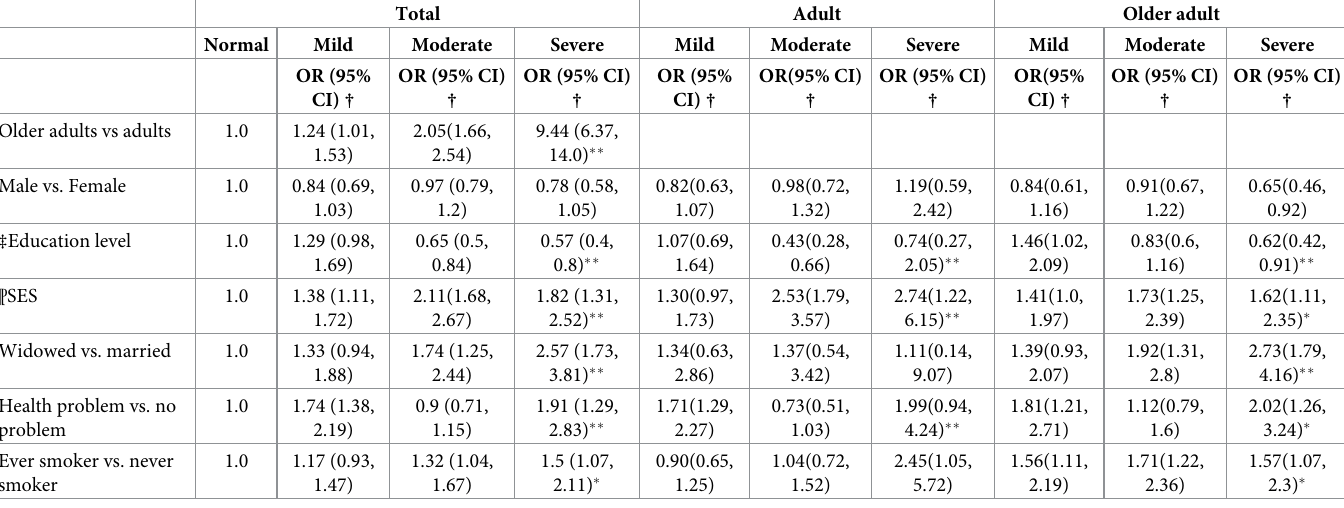
Table 5. Association of socio-demographic and other characteristics with the severity of psychological distress in a multi-nominal logistic regression model by adults and older